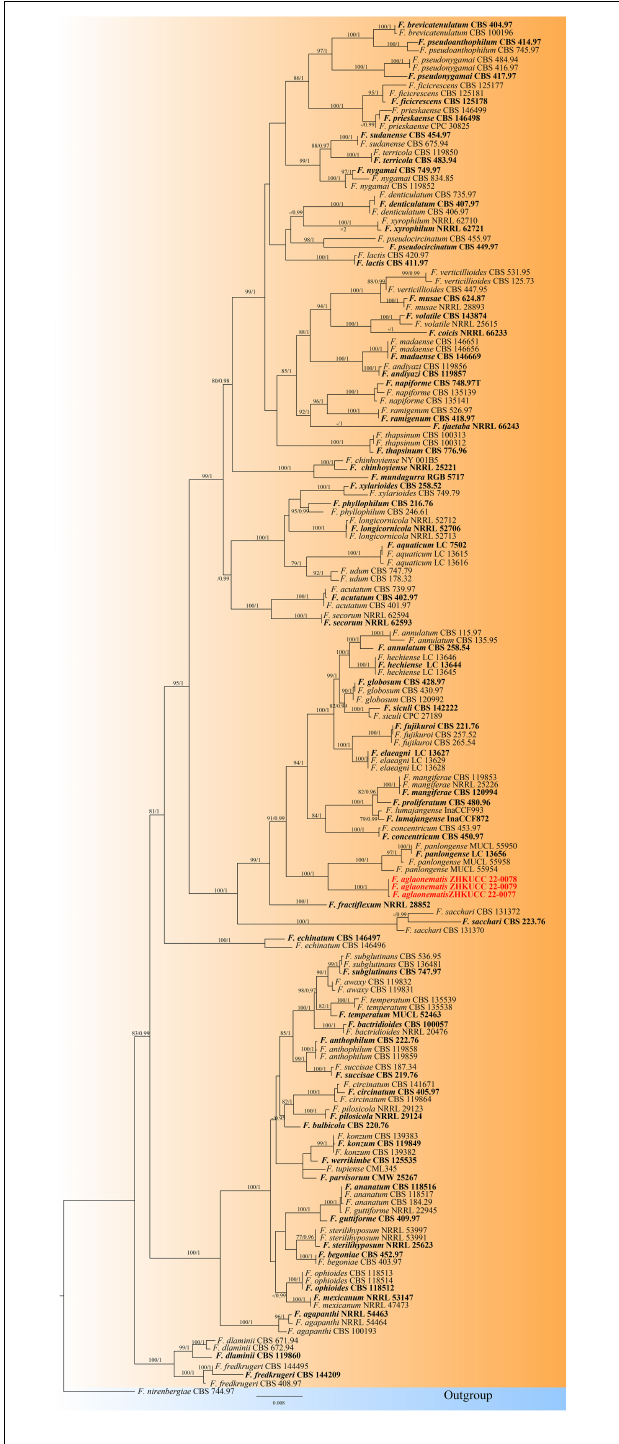
FIGURE 2 | The Best scoring RAxML tree obtained from the combined cmdA , rpb1 , rpb2 , tef1- α , and β -tubulin sequence alignment of the Fusarium fujikuroi complex. The maximum likelihood (ML) bootstrap support values ≥ 75% and Bayesian posterior probability (BYPP) higher than 0.90 are indicated at the nodes and branches. The scale bar indicates 0.07 changes per site. Ex–type/ex–epitype strains are in bold. New isolates recovered in this study are in red. Fusarium nirenbergiae (CBS 744.97) was used as an